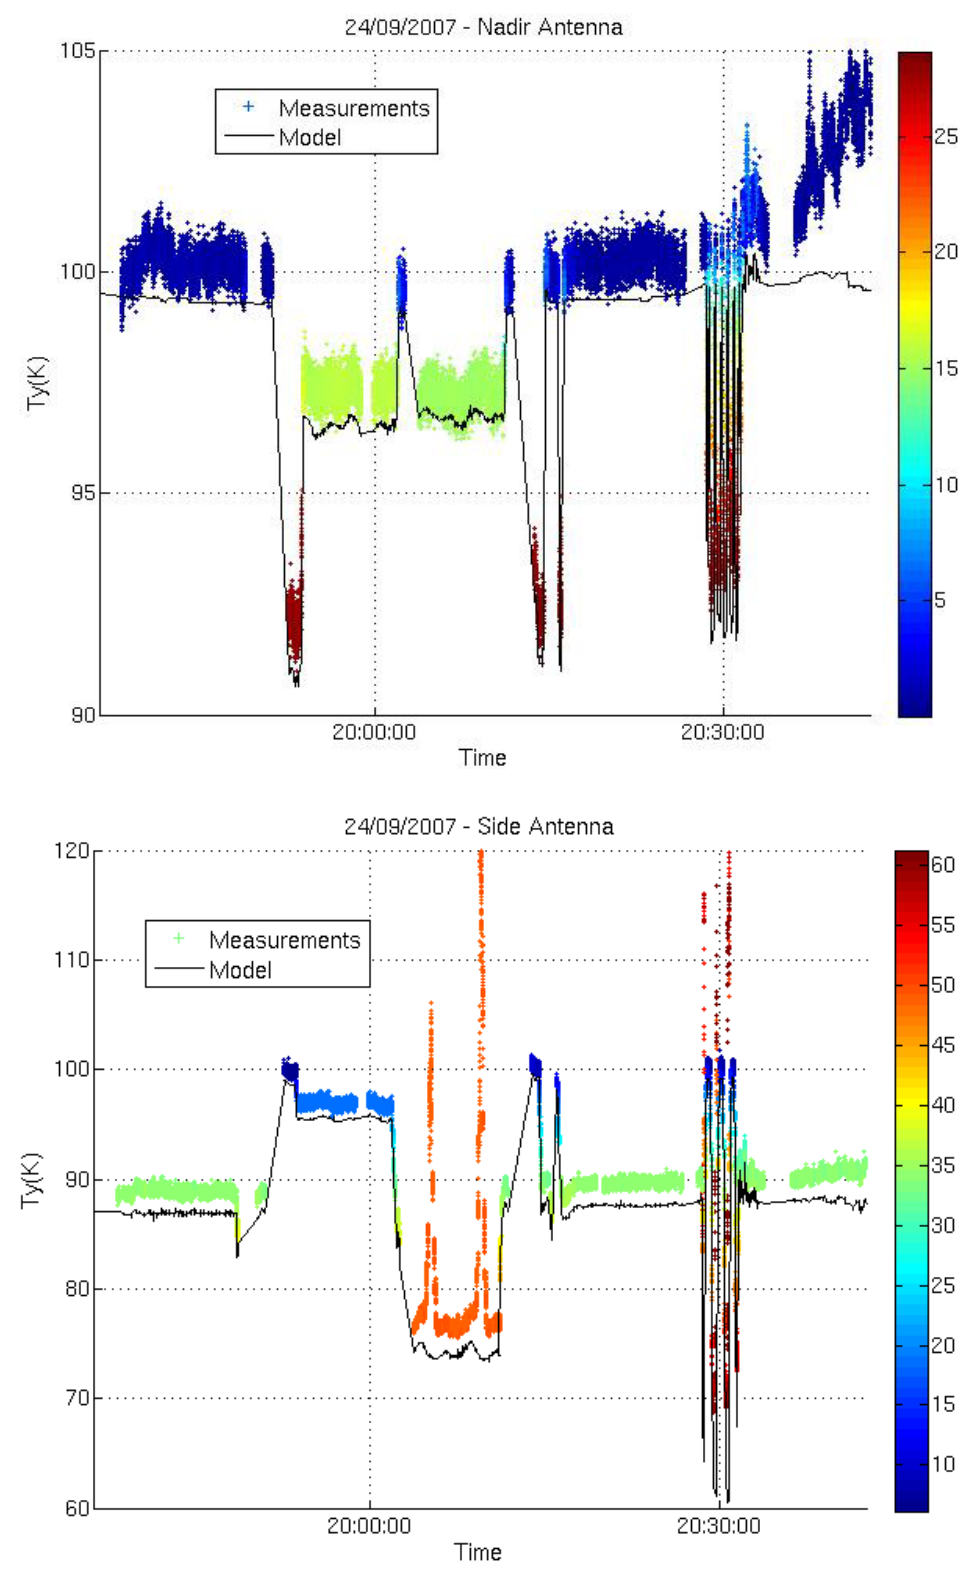
Figure 8. Measurements (8 ms average) recorded at the Y port (close to H-pol), by the nadir (top) and side (bottom) antennas on 24 September 2007. Incidence angles are indicated by the color coding. The simulated values of Ty are indicated by the black